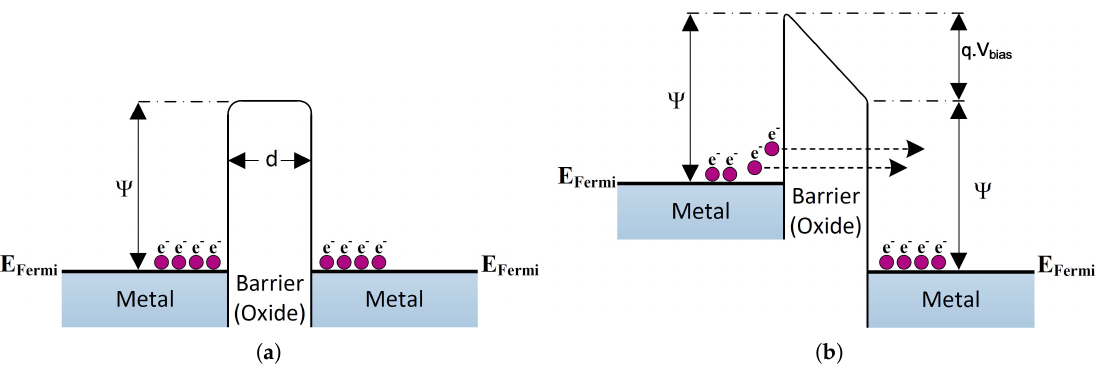
Figure 14. Energy band diagram for MOM contact: ( a ) Barrier formation, ( b ) Trapezoidal shaped barrier due to biasing